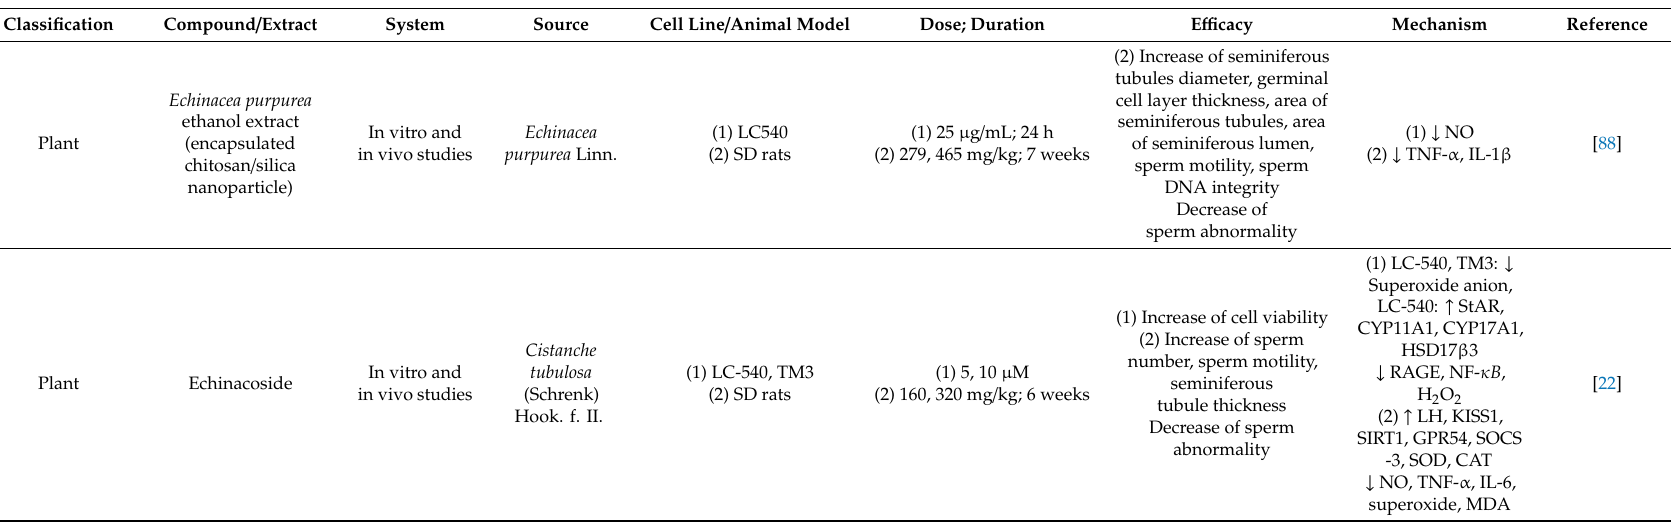
Table 3. Plant derived natural products and male infertility (in vitro and in vivo